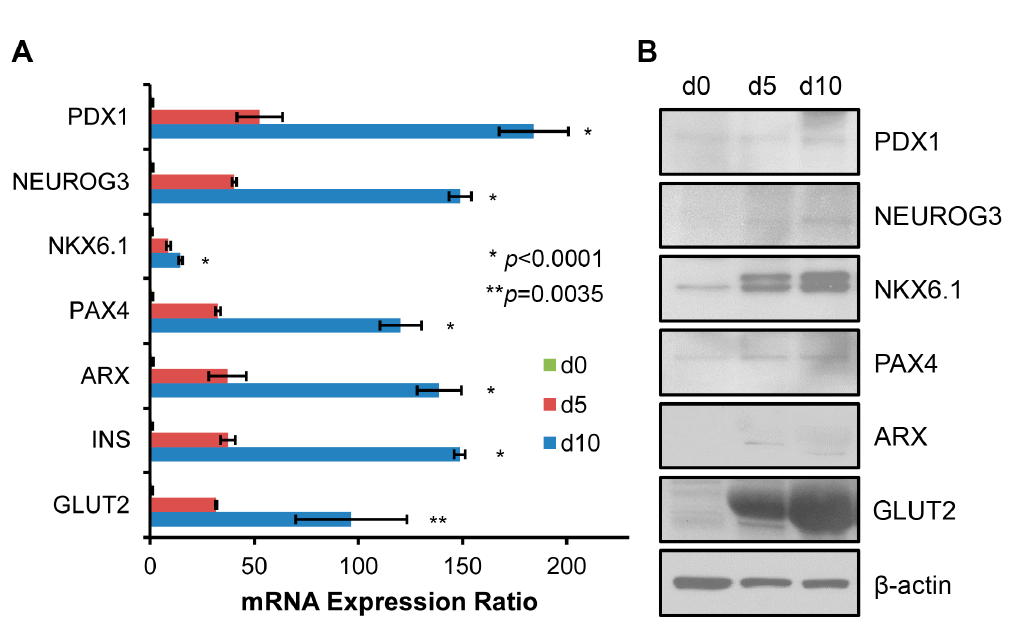
Figure 2. Differentiation of biomarkers in pancreatic lineage shown in the levels of ( A ) mRNA; and ( B ) protein. Every day 5 (or d5) and day 10 (d10) marker expression differed from one another and from d0 in mRNA. n = 3. Gene Descriptions: PDX1, pancreatic and duodenal homeobox 1; NEUROG3, neurogenin 3; NKX6.1, NK6 homeobox 1; PAX4, paired box 4; ARX, aristaless related homeobox; INS, insulin; GLUT2, glucose transporter 2.